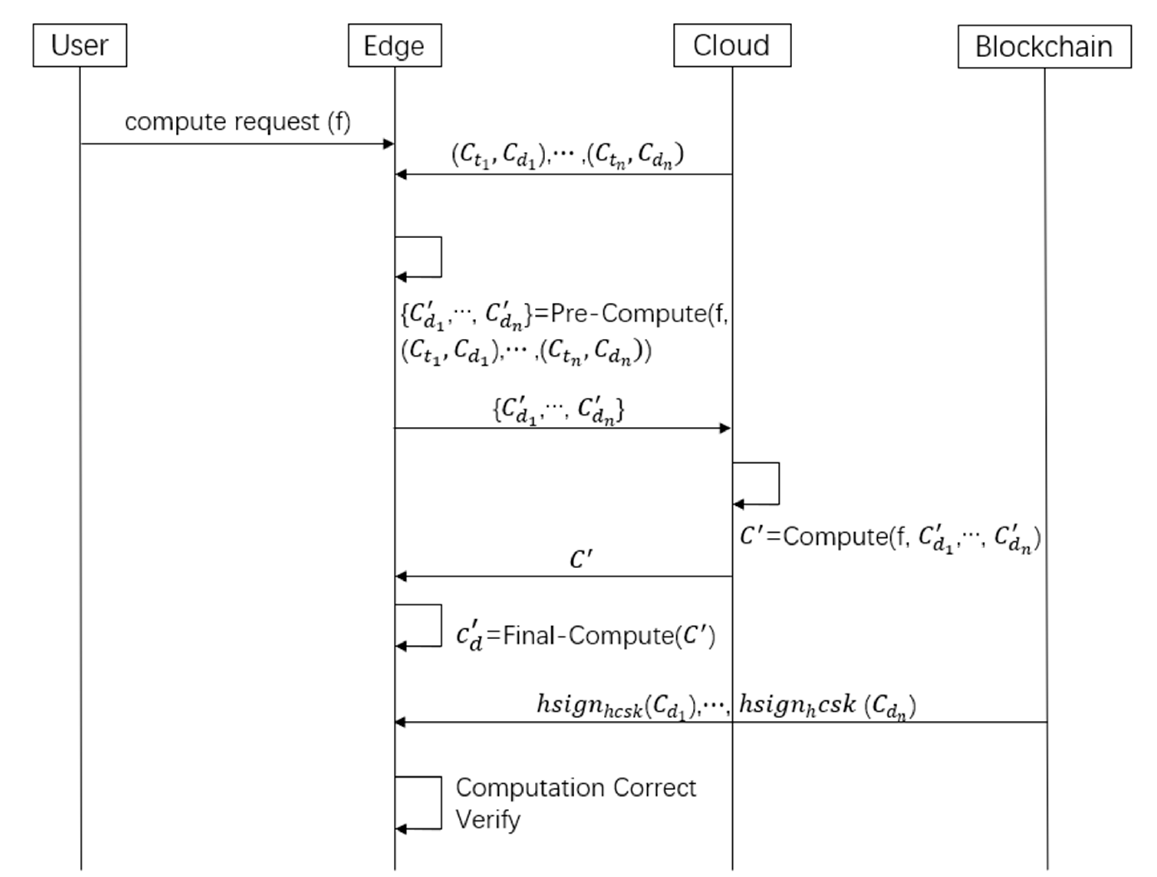
Figure 3. Ciphertext calculation process.